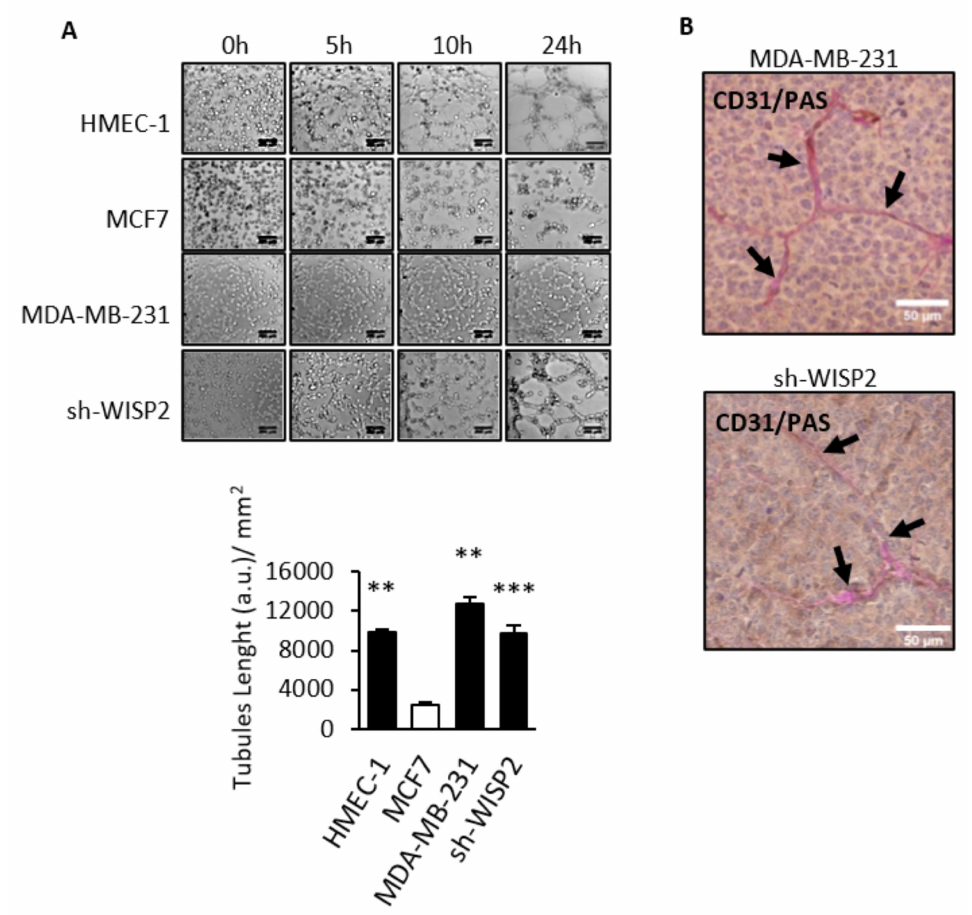
Figure 2. Expression of WISP2 correlates with vasculogenic mimicry (VM). Time-lapse video microscopy experiments were realized on endothelial HMEC-1 cells and breast cancer MCF7, MDA-MB-231, and sh-WISP2 cells. ( A ) Representative images undergoing VM and quantitation of VM length of tubes after 24 h. Experiments were realized at least 3 times and data are expressed as mean ± SEM. Scale bar = 200 µ m. ( B ) Thick paraffin sections of breast obtained from tumor xenografts of nude mice injected with MDA-MB-231 or sh-WISP2 human breast cell lines were subjected to CD31-Periodic Acid-Schiff (PAS) dual staining. Black arrows indicate VM channels with positive PAS and negative CD31 expression. (Scale bar = 50 µ m). ** p < 0.01; *** p <